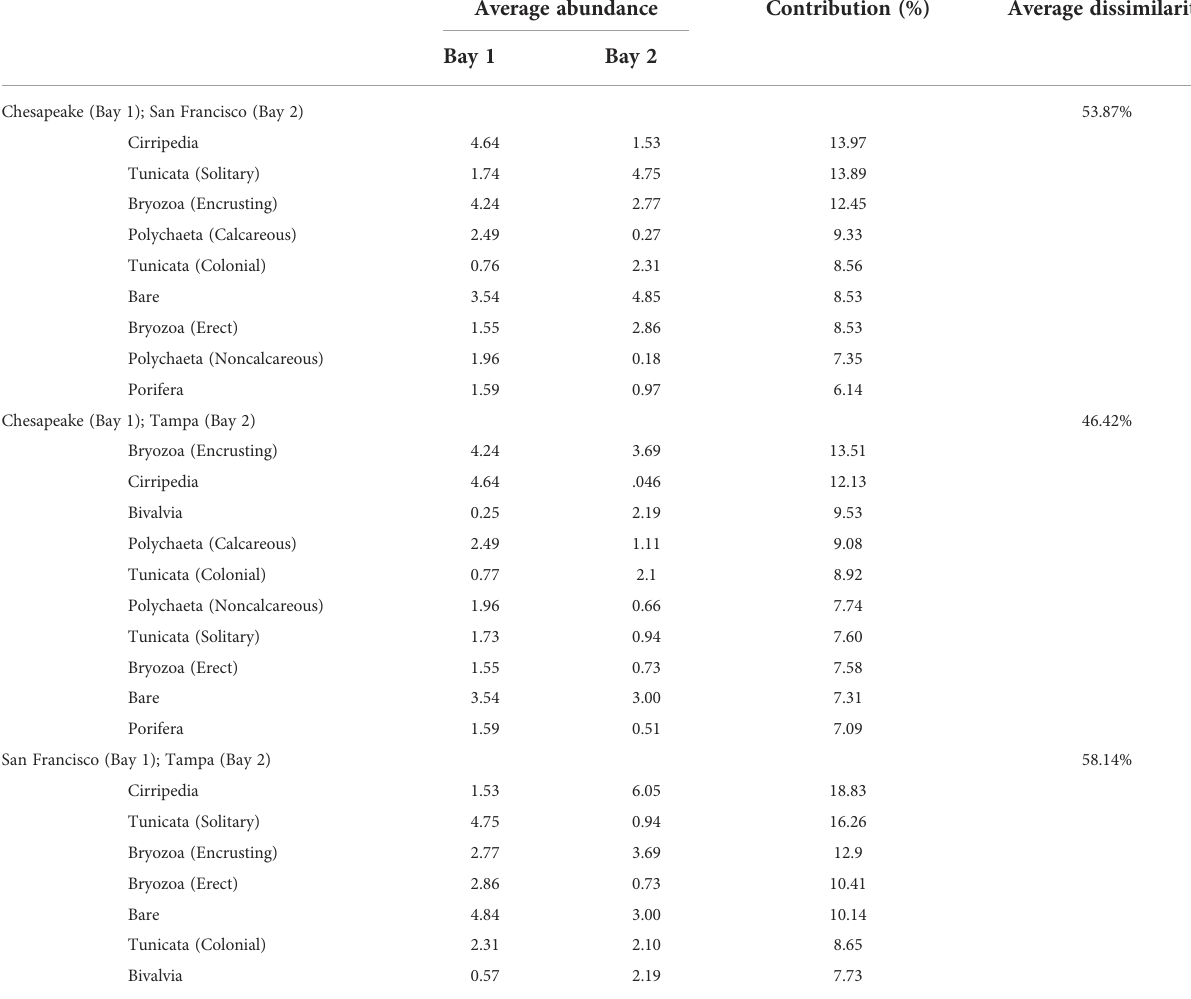
TABLE 2 SIMPER dissimilarity (%) of functional community composition of differing bays (Chesapeake, San Francisco, and Tampa) for the summer-deployed panels only deployed across periods 1 and